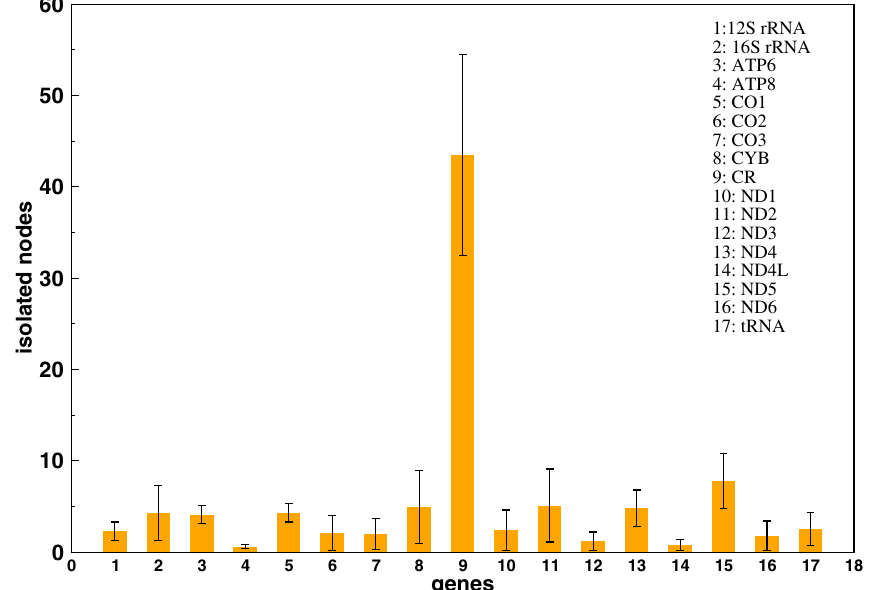
Figure 4. The mean of the number of isolated nodes for corresponding genes across all the altitudes.